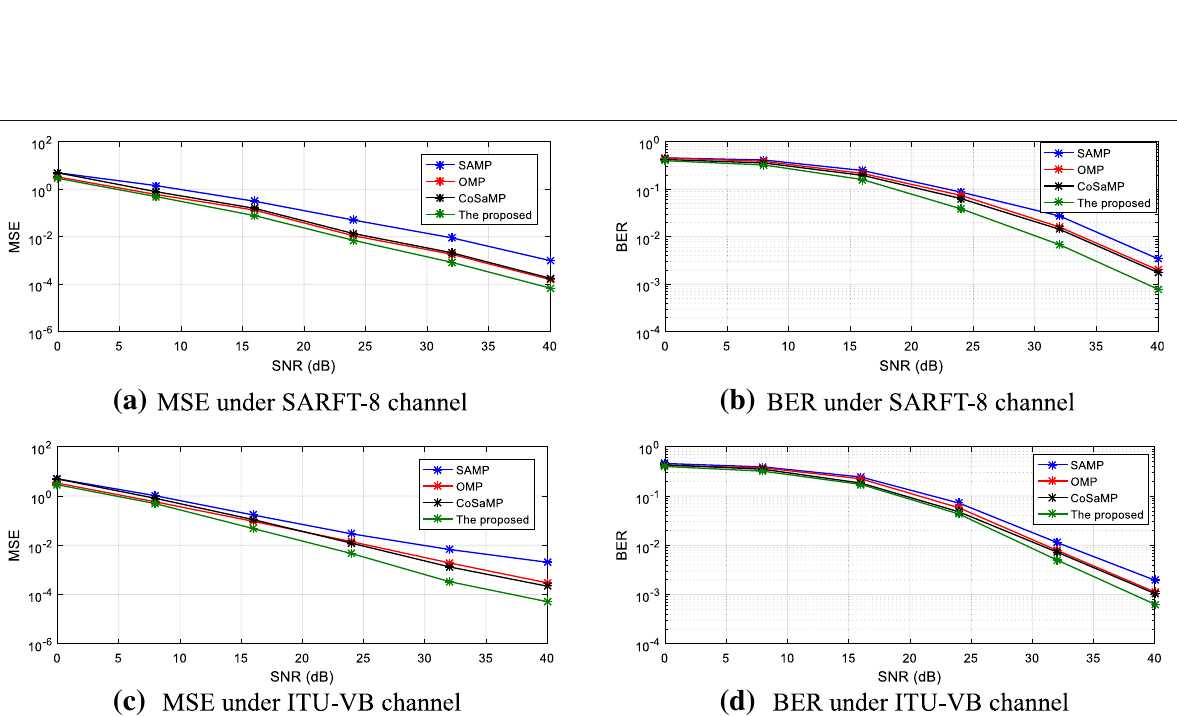
Fig. 9 The performance comparison of different CS channel estimation schemes in 16 × 16 MIMO-OFDM system with f c = 0.05 and f max = 20